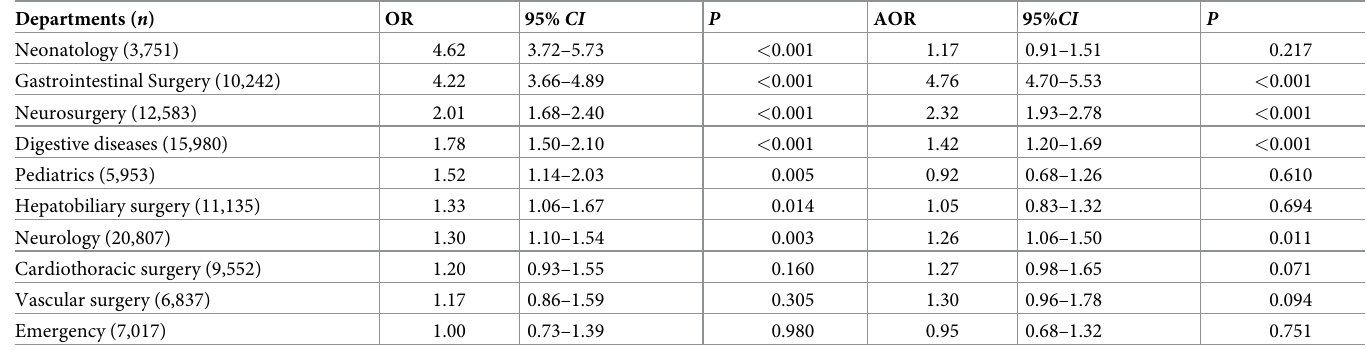
Table 5. Logistic regression analysis of the OR and the AOR of lipemia in the top ten departments (n = 103,857). Departments ( n )